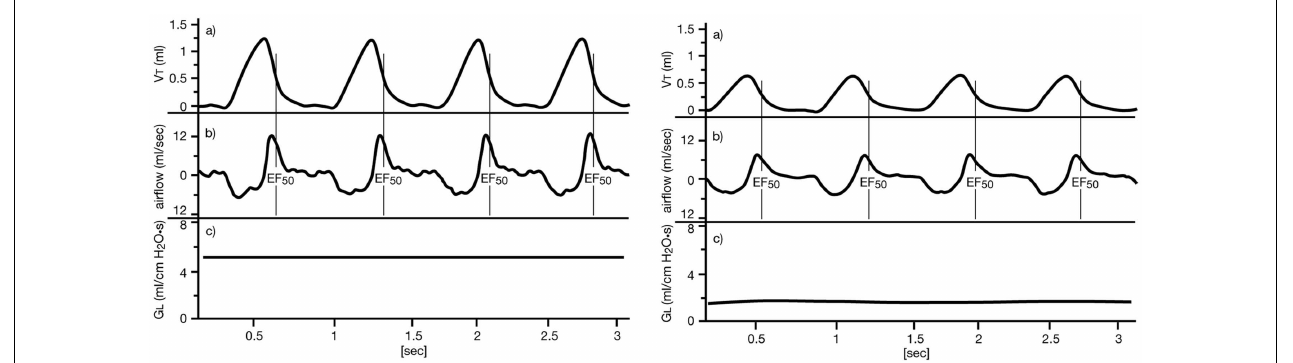
signal over time, a vertical line indicates the value of EF 50 at midexpiratory V T . Middle tracing: corresponding airflow signal from the pneumotachograph during expiration (above zero) and inspiration (below zero). Lower tracing ( G L ): corresponding lung conductance G L = 1/R L [reprinted with permission from Glaab et al. (2002)].